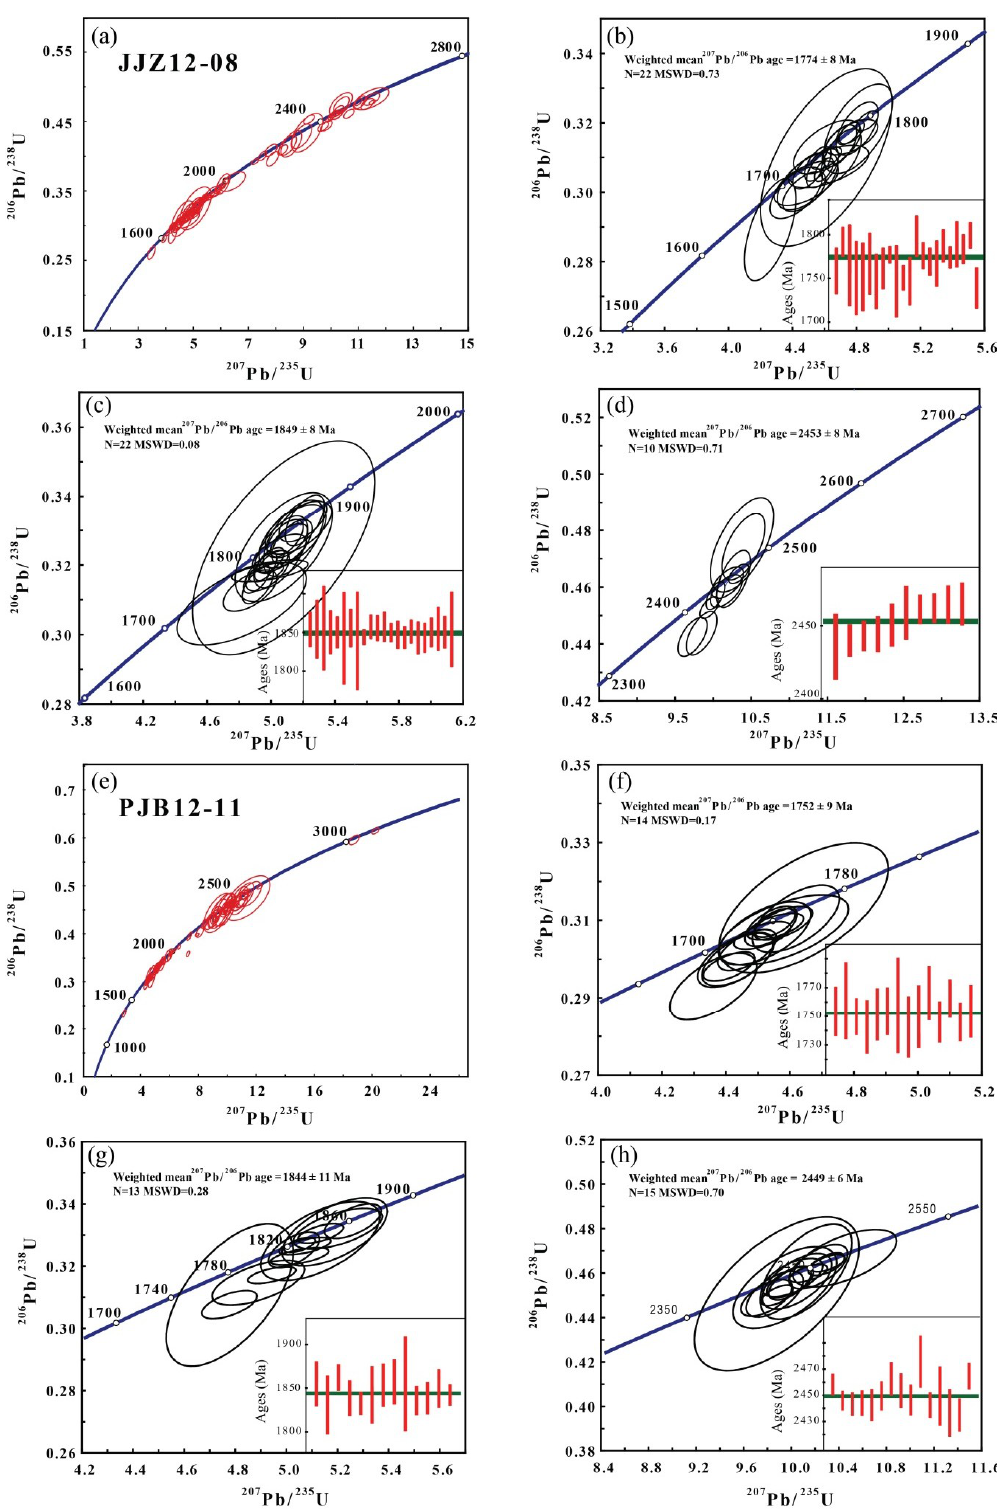
Figure 6. U-Pb concordia and peak age distribution diagrams of zircon grains from samples JJZ12-08 ( a – d ) and PJB12-11 ( e – h ) collected from the Chuanlinggou Formation.